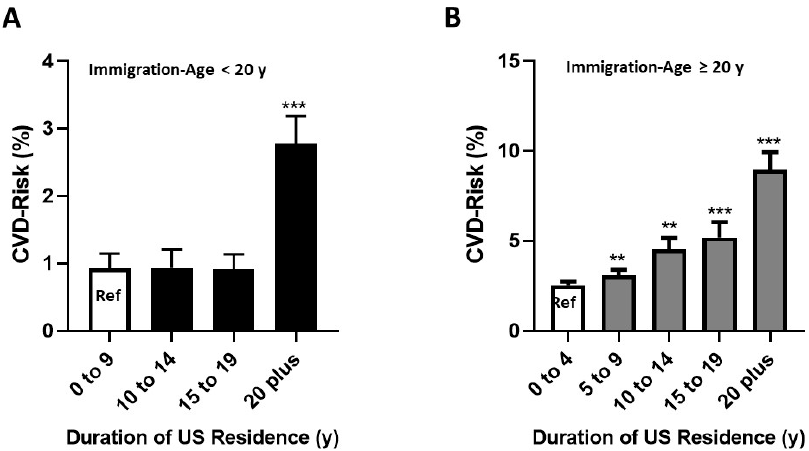
Figure 4. CVD-Risk by Duration of Residence in the United States for each